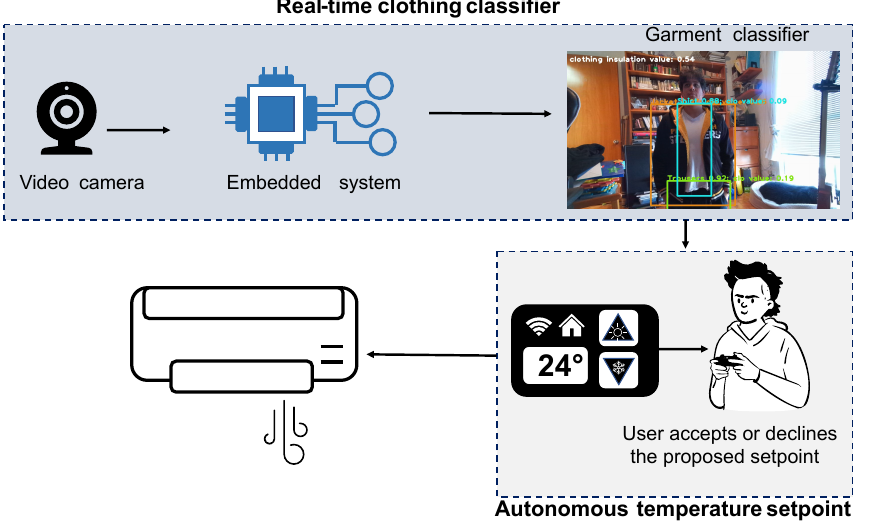
Figure 6. Proposed block